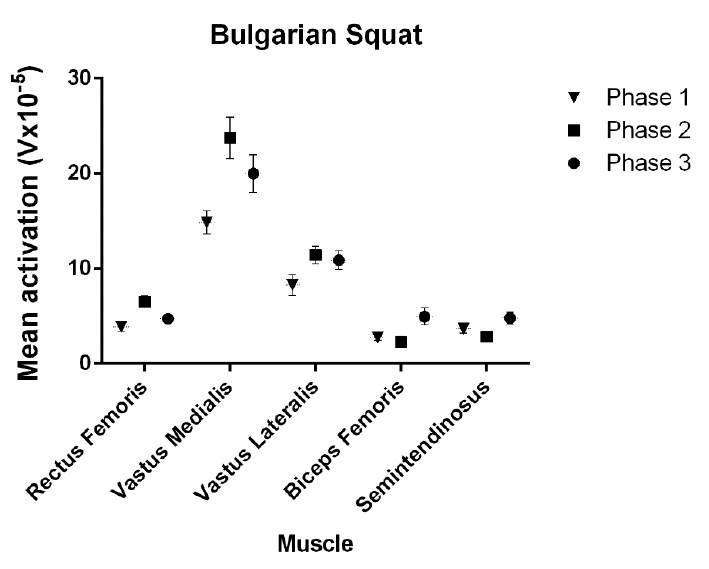
Figure 5. Mean activation (Vx10 -5 ) of all the muscles in each phase in Bulgarian squat. The first phase corresponds to the descent, the second to the isometric phase and the third to the ascent. The vertical lines around the data represent the SD.